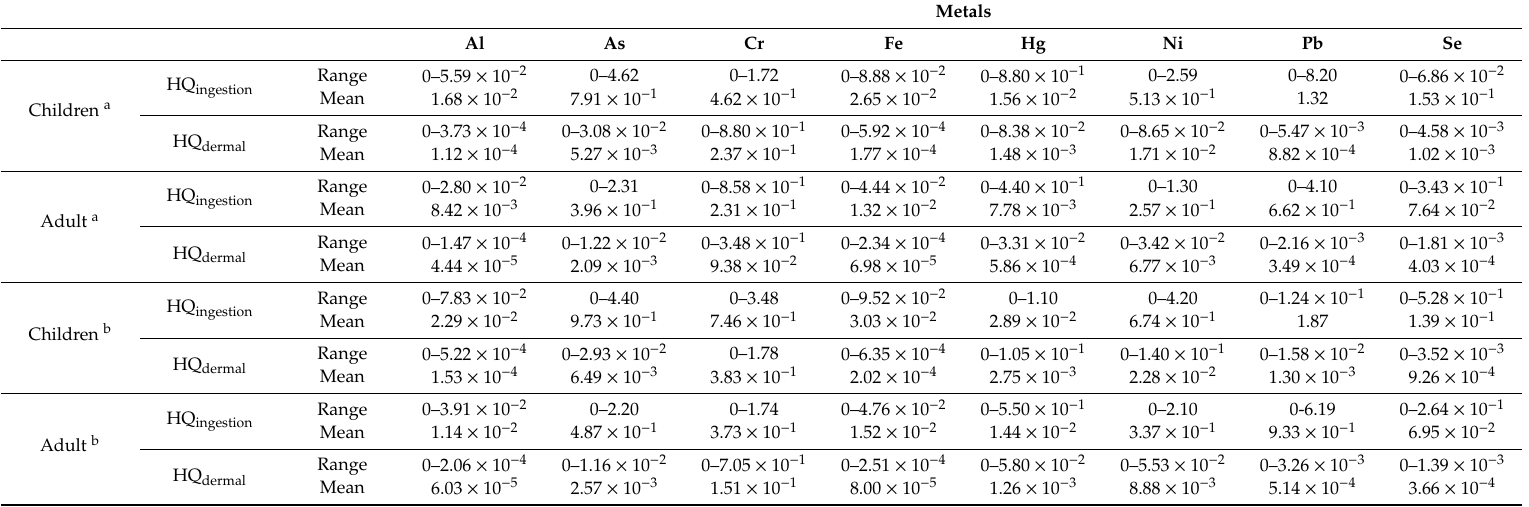
Table 5. Hazard quotient (HQ) of di ff erent ESEs during pre- and postmonsoon